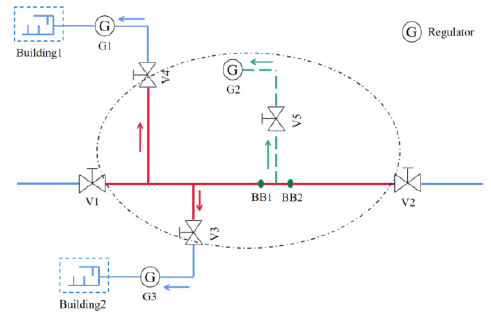
Figure 3. Illustration of new regulator connection.